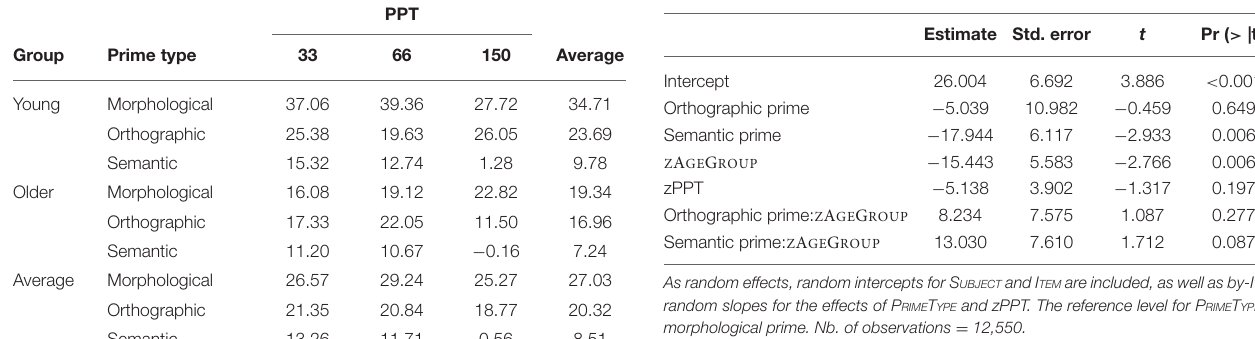
TABLE 4 | Lmer model for priming effects with fixed effects of P RIME T YPE , Z A GE G ROUP , and zPPT as well as the interaction between P RIME T YPE and Z A GE G ROUP